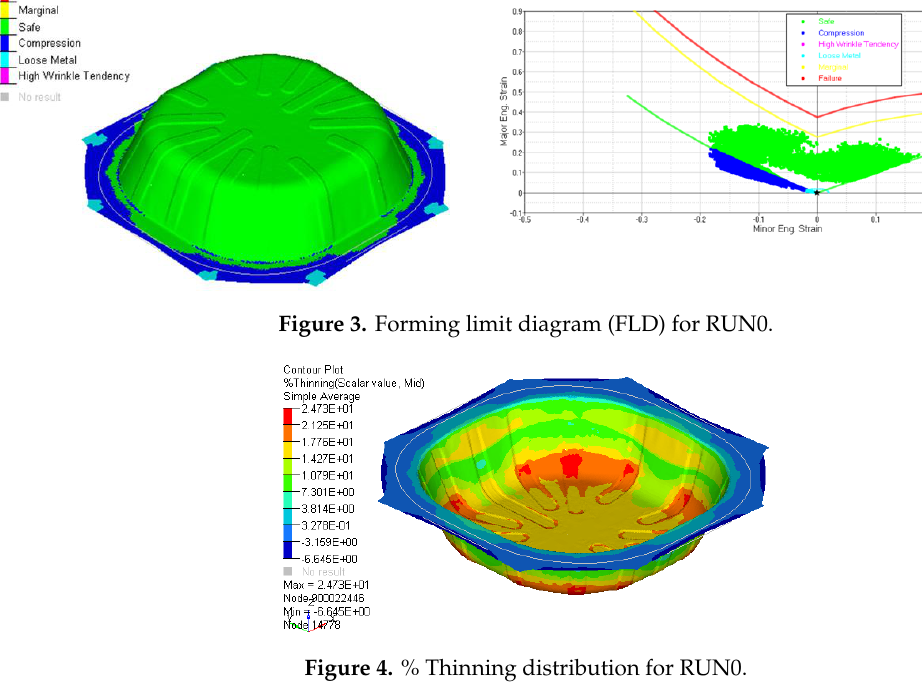
Figure 4. % Thinning distribution for RUN0.